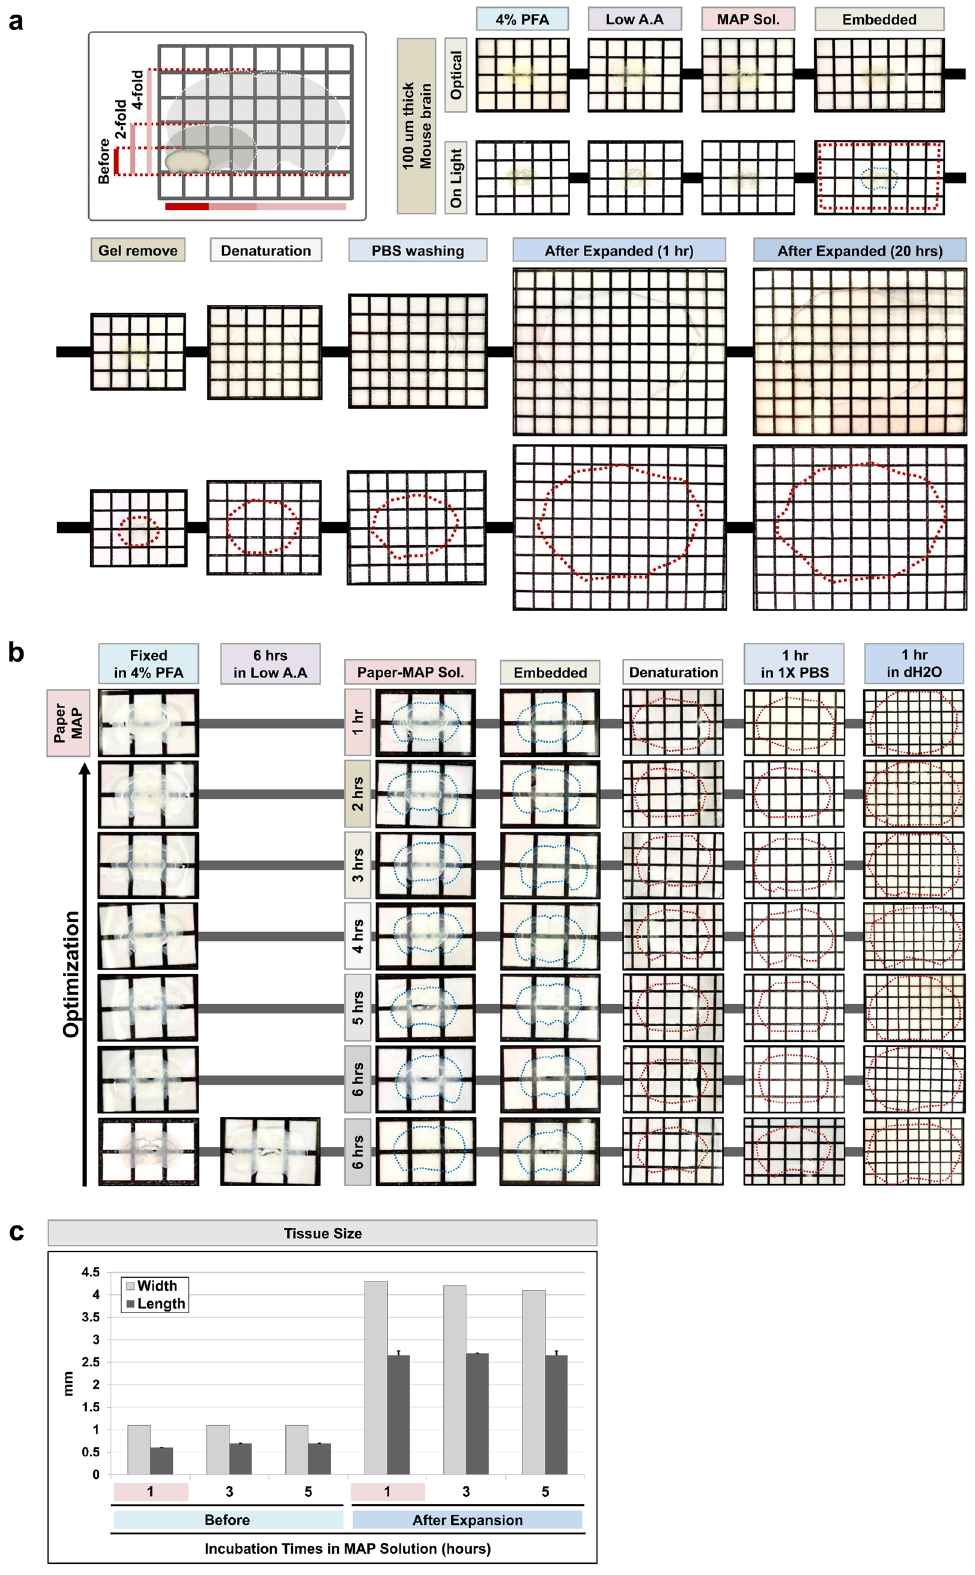
Figure 2. Comparison of tissue clearing and expansion via optimized Paper-MAP. ( a ) Optical transparency of 100 μm-thick mouse brain sections processed via Paper-MAP optimization. ( b ) Effect of varying incubation times in low acrylamide (A.A) solution and Paper-MAP solution on tissue transparency, using 100 μm-thick rodent brain sections. ( c ) Comparison of gel size (width and length) before and after expansion, with varying incubation times in Paper-MAP solution. Quantification of total width and length from different ratio combinations. Data are presented as mean ± SD (standard deviation); n = 5 for each experimental